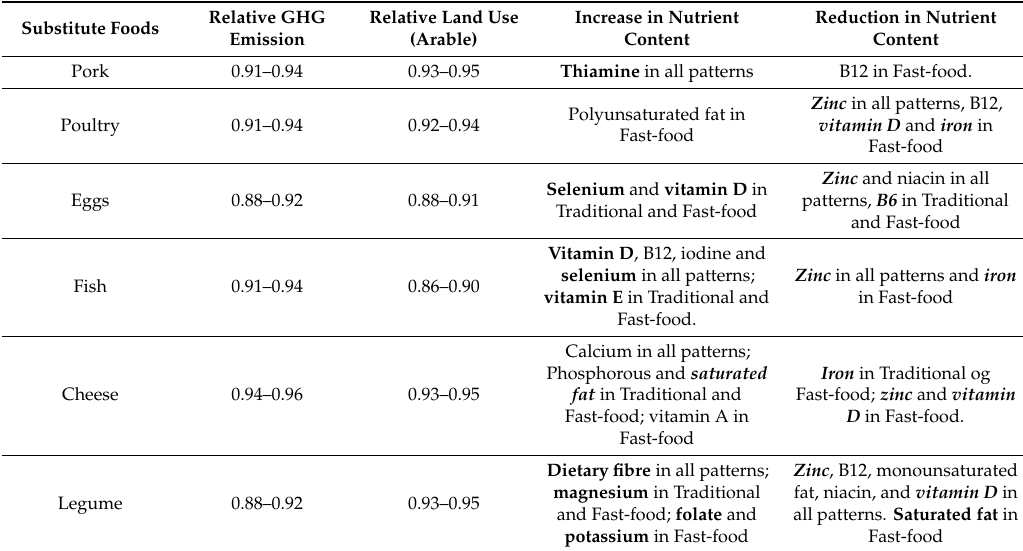
Table 7. Changes in greenhouse gas (GHG) emission and land use and an indication of relevant nutrients / food characteristics that change at least 5% by substituting beef products with other foods in the dietary patterns (Traditional, Green, and Fast-food) adjusted to the same energy intake (10 MJ / day). Positive changes with regard to nutrients of concern are indicated in bold, negative changes with regard to nutrients of concern are indicated in bold and italic